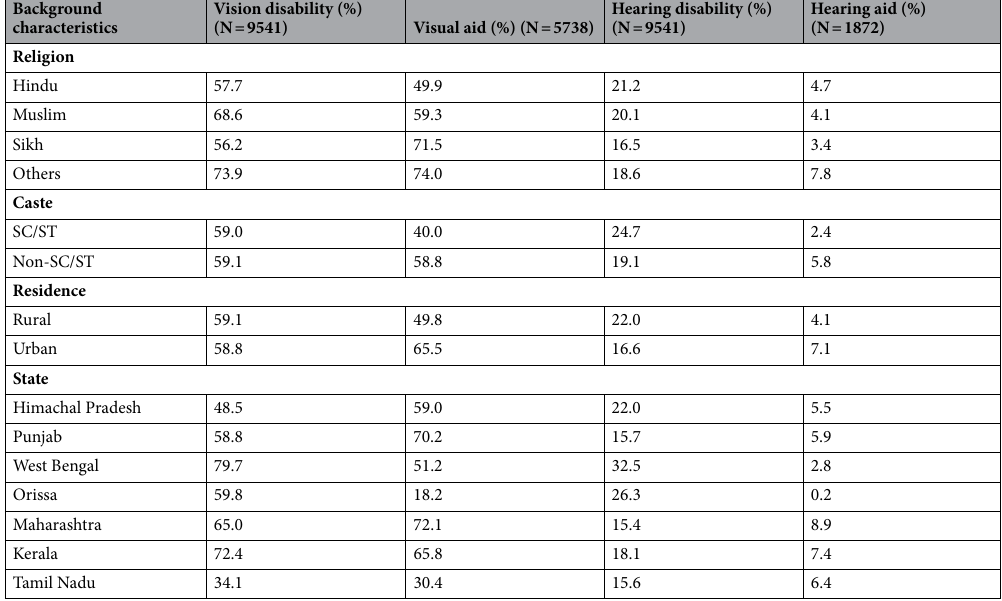
Table 2. Bivariate association between background characteristics and vision & hearing disability along with AID seeking behavior among older adults in India. %: percentage, SC/ST: scheduled caste/scheduled